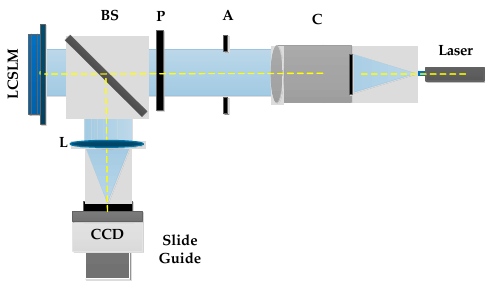
Figure 7. Experimental diagram of the physical deep learning wave-front sensor. C = collimator; A = aperture; P = polarizer; BS = beam splitter; LCSLM = liquid crystal spatial light modulator; and L = lens; CCD = charge-coupled device.